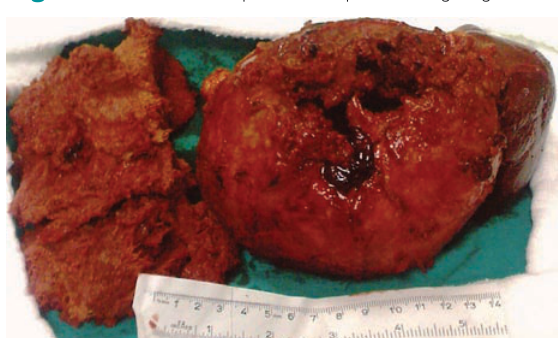
Figure 3. The resected specimen composed of surgical